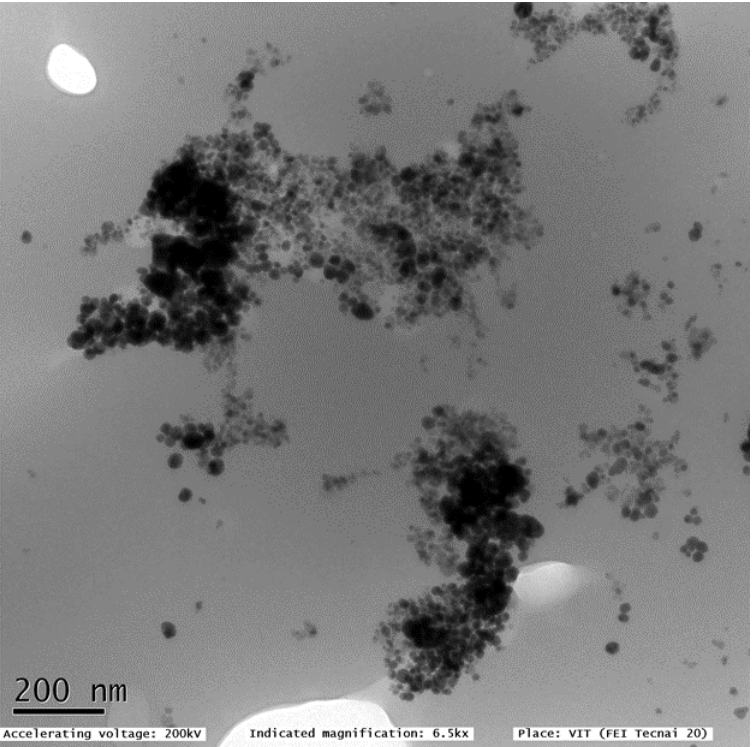
Figure 2. Transmission electron microscopy (TEM) micrograph of AgNPs produced with Ulvan from Ulva lactuca .